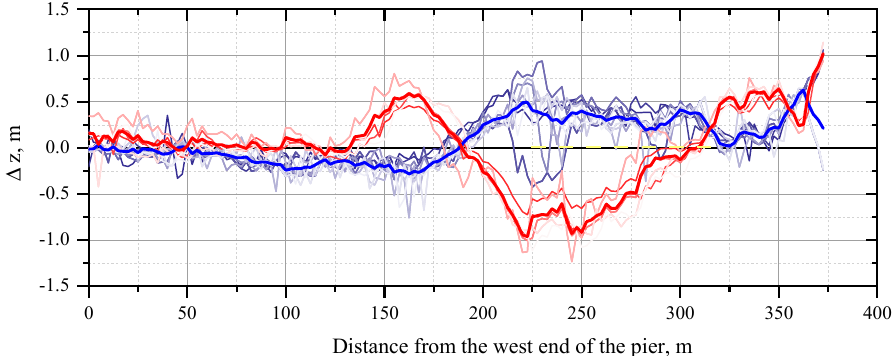
Figure 12. Spatial and temporal evolution of bottom elevation changes ( Δ z) showing the average of all measured profiles (blue—2016, red—2017).